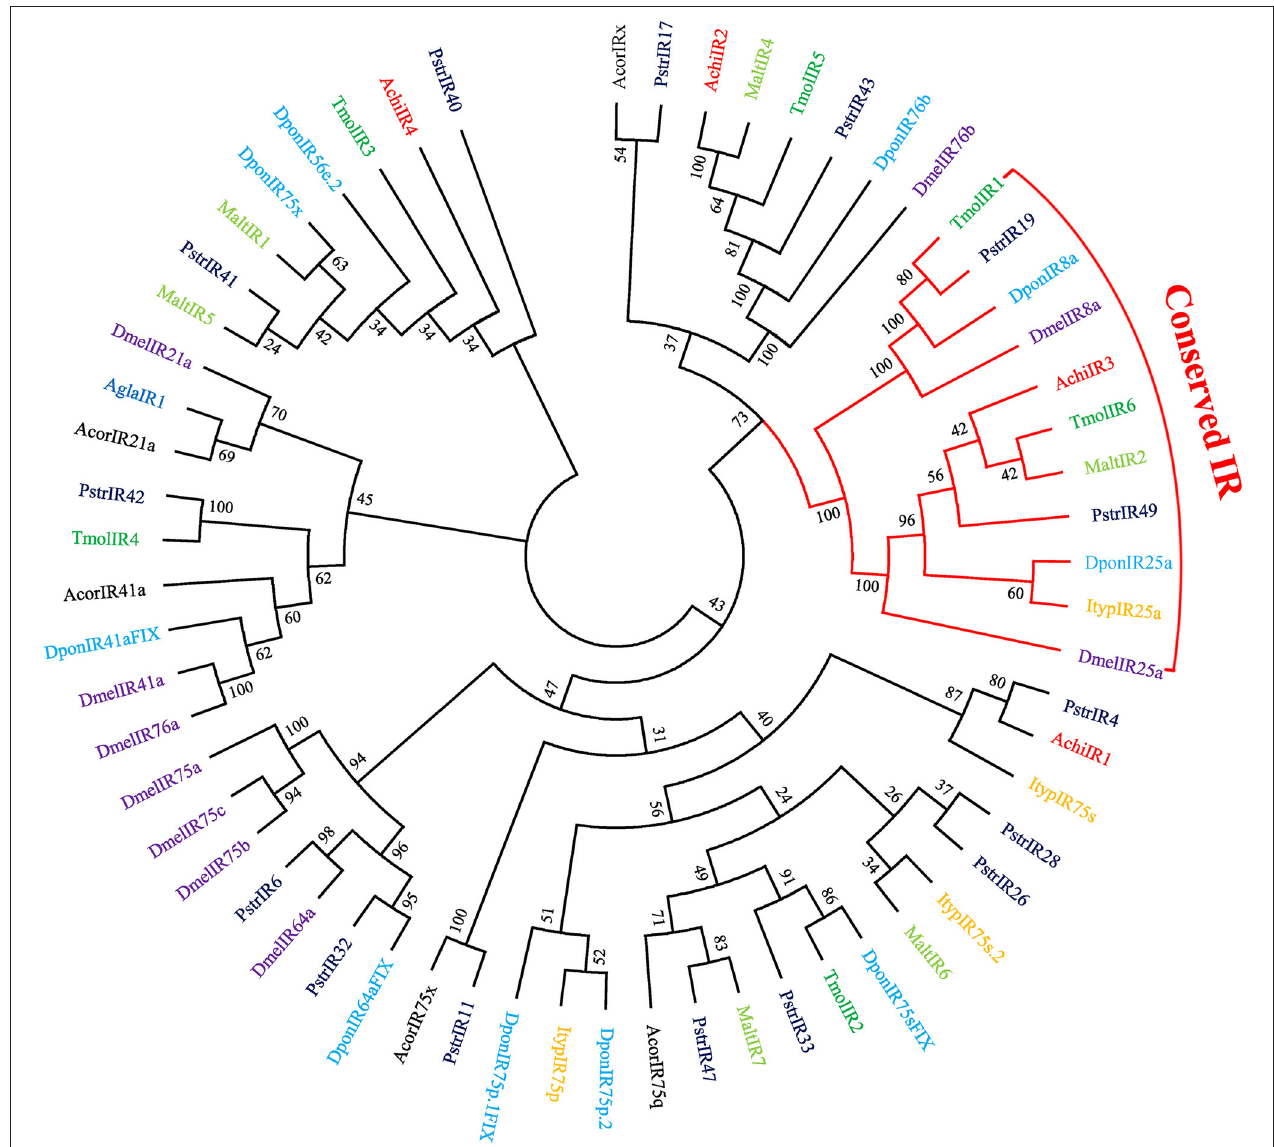
FIGURE 4 | Phylogenetic tree of putative ionotropic receptor (GR) genes. The tree was constructed using MEGA6 with Neighbor-joining method. Achi: A. chinensis ; Agla: A. glabripennis ; Dpon: D. ponderosae ; Ityp: I. typographus ; Pstr: P. striolata ; Acor: A. corpulenta ; Malt: M. alternates ; Tmol: T. molitor ; Dmel: D. melanogaster